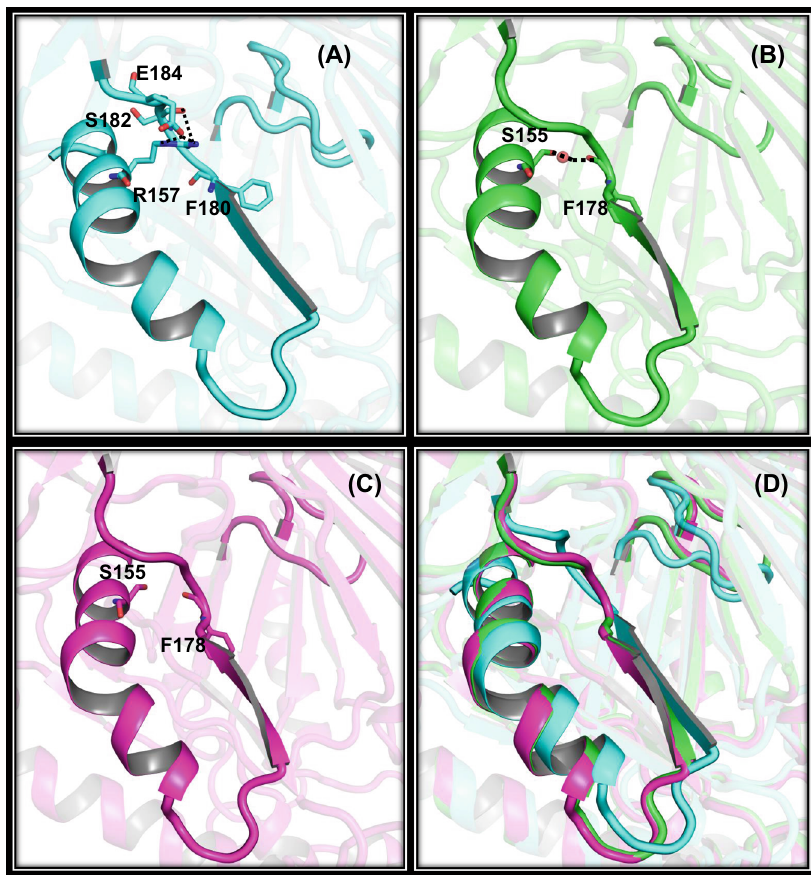
Fig. 3 Key residue variation in OqxB substrate-binding pocket. Lengthy positively charged arginine residue R157 and its intra-molecular interactions with E184 residue are highlighted in OqxB ( A ). The small hydrophilic residue S155 is present in AcrB ( B ) and MexB ( C ) at identical positions, superposition of all the three structures ( D ). The S155 side chain demonstrated water-mediated interaction with the F178 main chain carbonyl oxygen atom in the case of AcrB. The OqxB structure is shown with cyan cartoons whereas AcrB and MexB are shown as green and magenta cartoons, respectively. Residues labeled accordingly and intra-molecular interactions depicted as broken lines. All the three structures superimposed to highlight the conformational change at β - sheet and loop portion of OqxB. The g-loop showed in all three structures for better